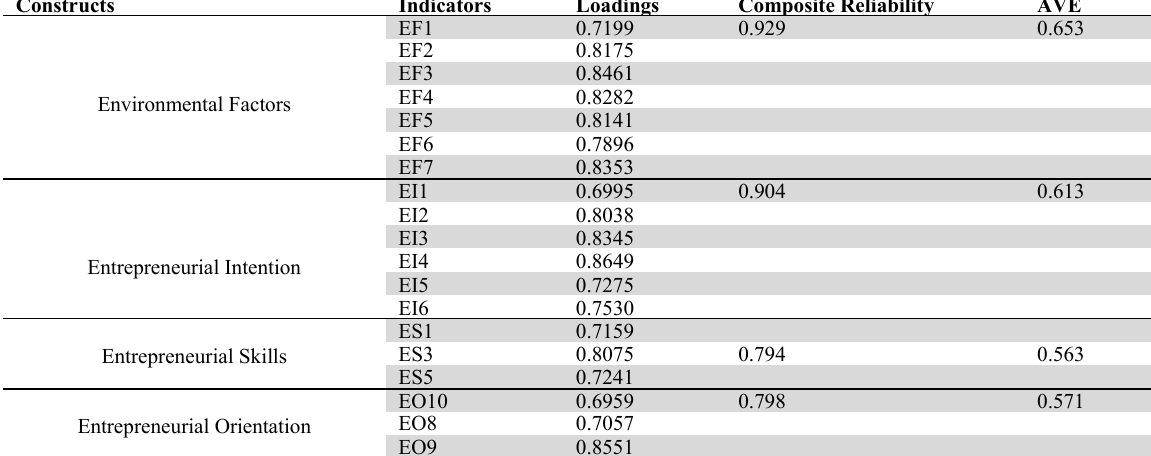
Item Loading, Internal Consistency, and Average Variance Extracted